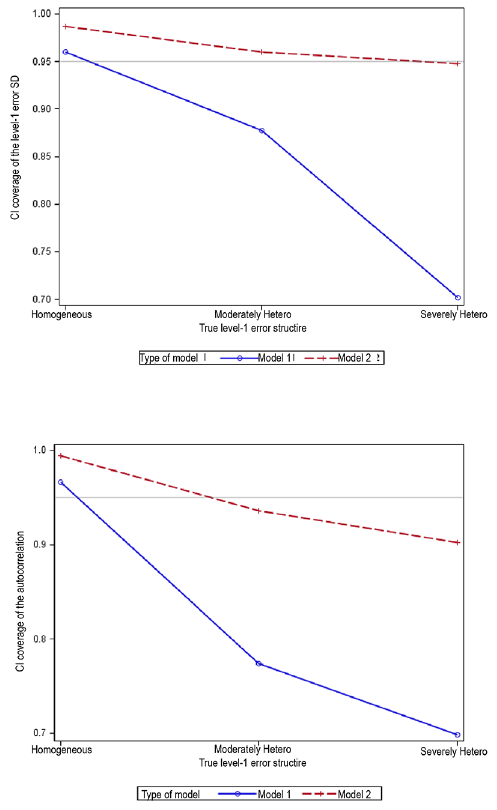
Line Graph Depicting Average ci Coverage of the Level-1 Error SD and Autocorrelation as a Function of the Two- Way Interaction Effect Between the Type of Model and the True Level-1 Error